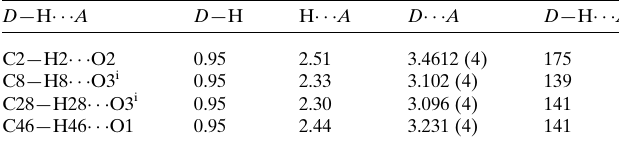
Table 1 Hydrogen-bond geometry (A˚ , (cid:3) ).